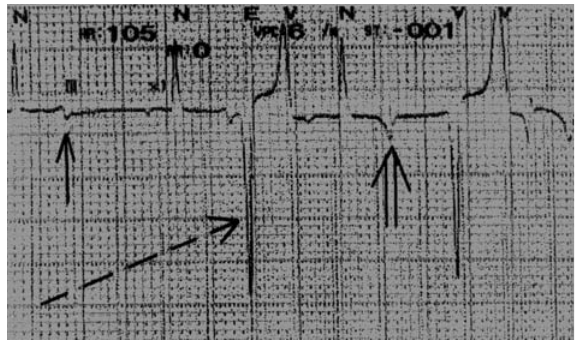
FIG. 3 An example of cardiac memory T waves. The third and fifth beats in this tracing are PVCs (broken arrow). Note the bifid T waves before the first PVC (arrow), and the inverted T waves after the PVCs (double arrow). The T wave retains the vector of the QRS complex of the PVC, hence the name “cardiac memory”